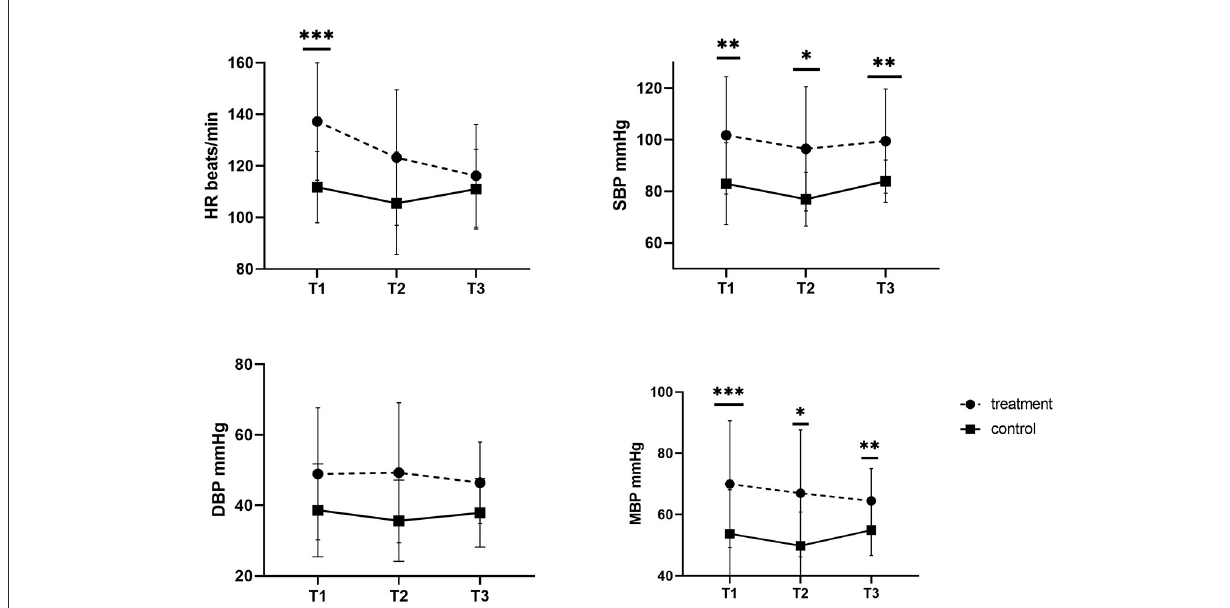
FIGURE1 Systolic, diastolic, and mean blood pressure (SBP, DBP, MBP) and heart rate (HR) in dams without (control group) and with (treatment group) fluid coload at different time points. * p = 0.01. ** p = 0.02. *** p = 0.03.